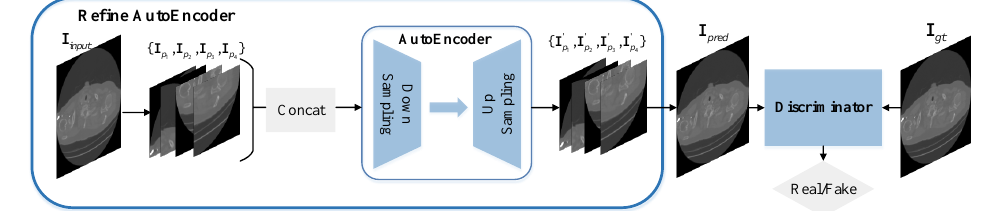
Figure 6. The overall architecture of our proposed Refine-AAE model in stage